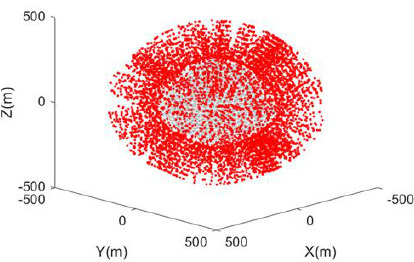
Figure 3. The distribution of sample points.